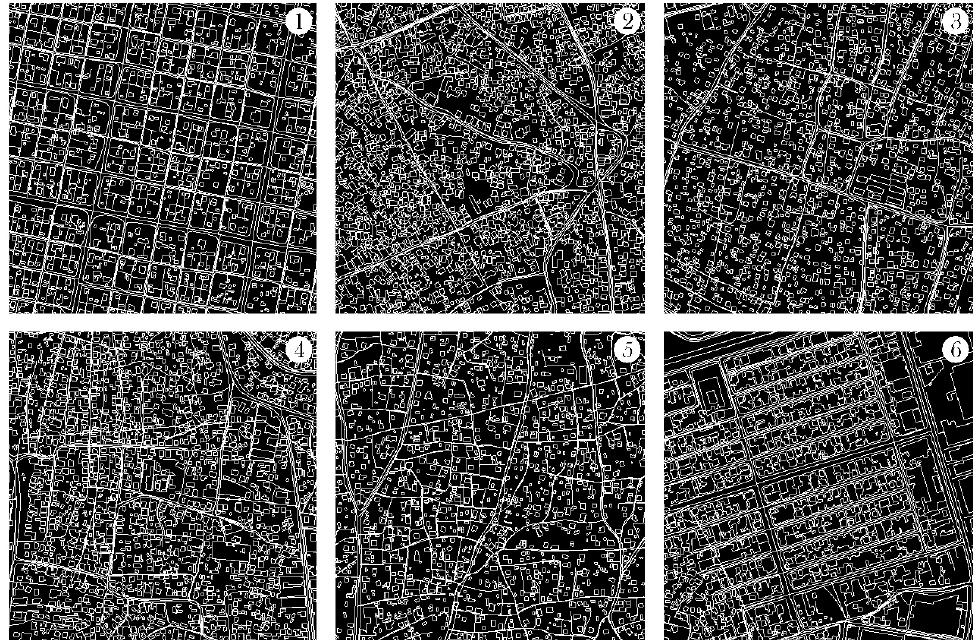
Figure 7. Plurality and polymorphism of the urban fabric of Maputo’s informal settlements. (source: created by the authors using the CAD basemap of the municipality of Maputo). Legend: 1—Laulane; 2—Chamanculo; 3—Inhagoia; 4—Mafalala; 5—Helene B; 6—Airport A.